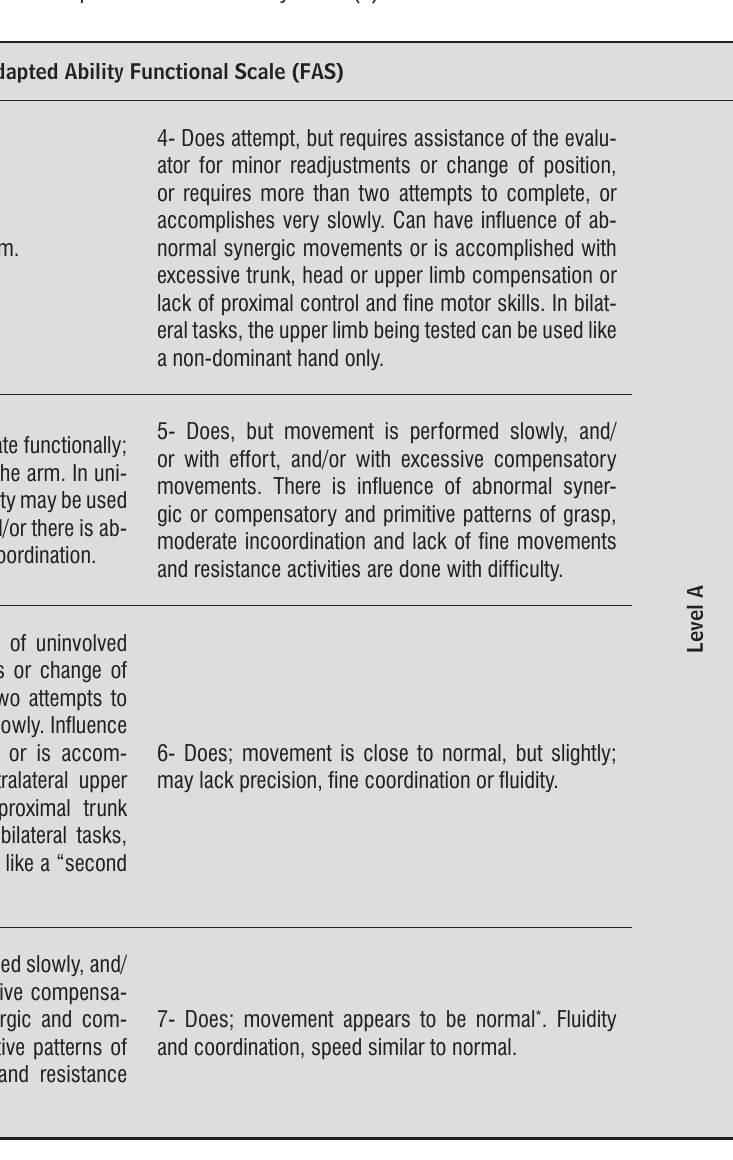
Table 3 - Adapted Functional Ability Scale